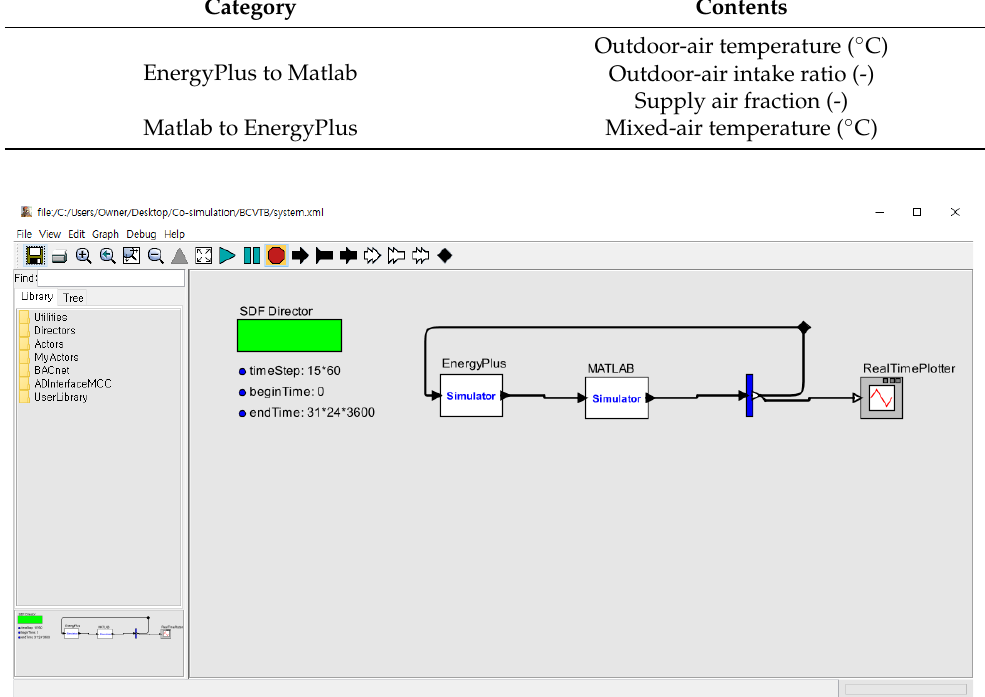
Figure 4. System model that links EnergyPlus with Matlab